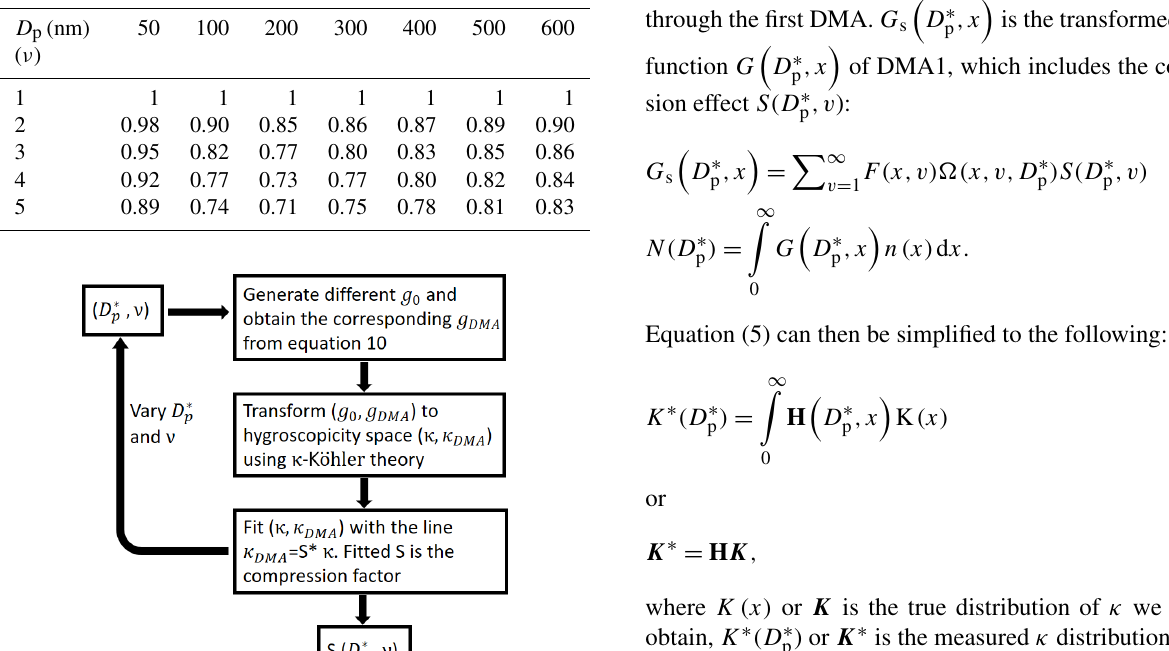
Table 1. Values of the hygroscopicity compression factor for aerosol particles with different electrical mobility diameters at 85% RH.